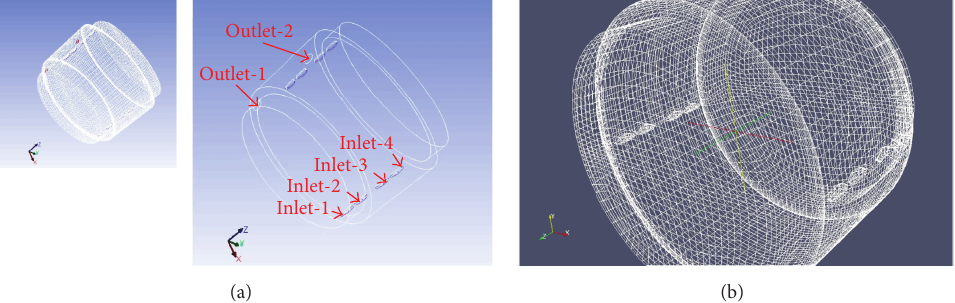
Figure 5: 3D grids system in OpenFOAM: (a) marked with boundaries and (b) example view of full grids system, approximately 200 k hexahedral meshes.